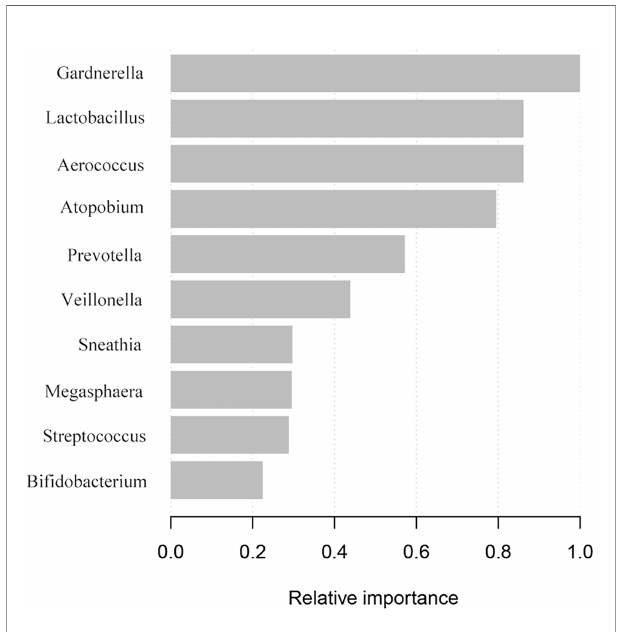
FIGURE 4 | Screening of vaginal microbiota that contributed to TP diagnosis. The XGBoost machine learning tool utilized vaginal microbiome data to diagnose early pregnancy location.